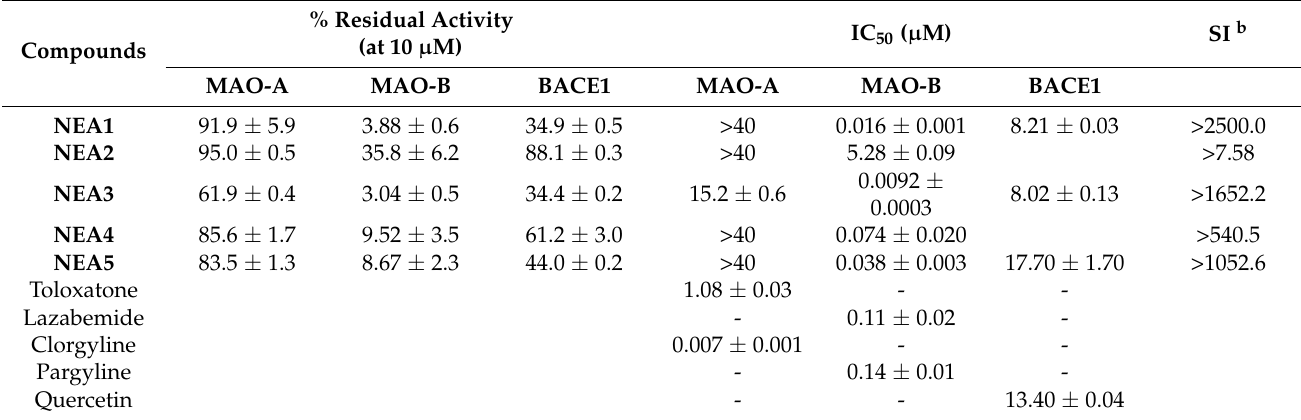
Table 1. MAOs and BACE1 inhibition profiles of nitro-bearing enamides a